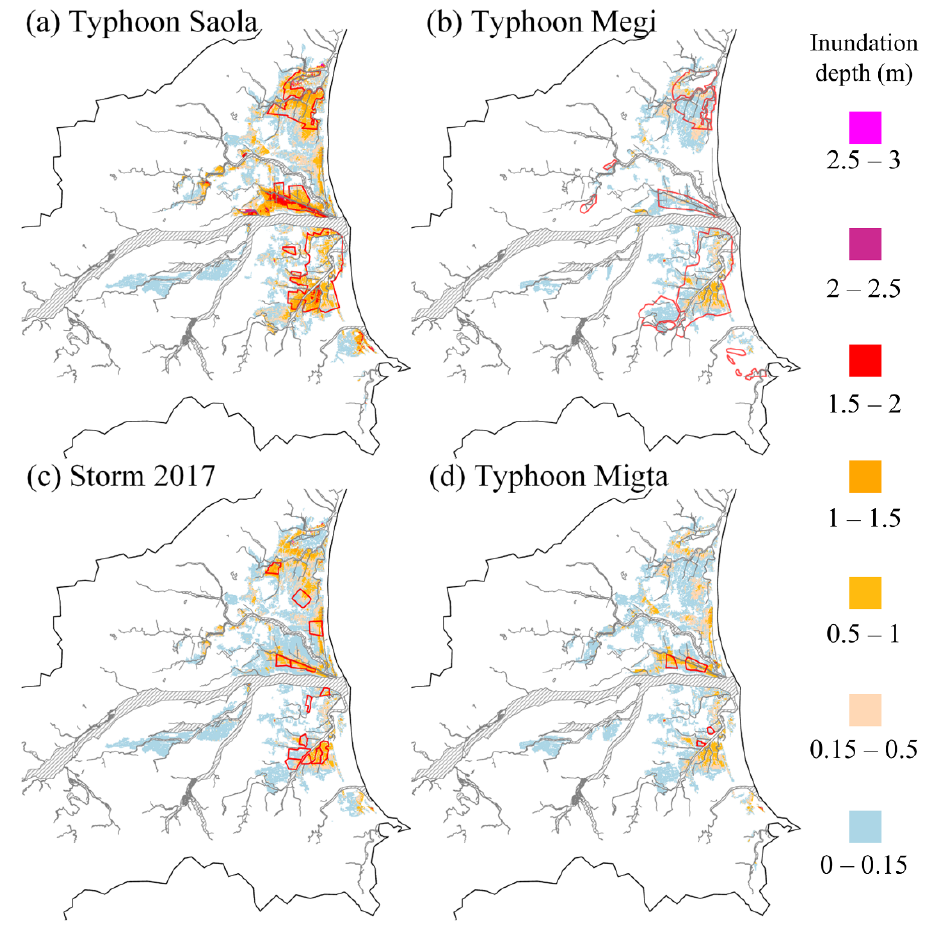
Figure 11. Comparing the flooding maps forecasted by QPF-RIF and flooding area reported by EMIC in 4 historical events.